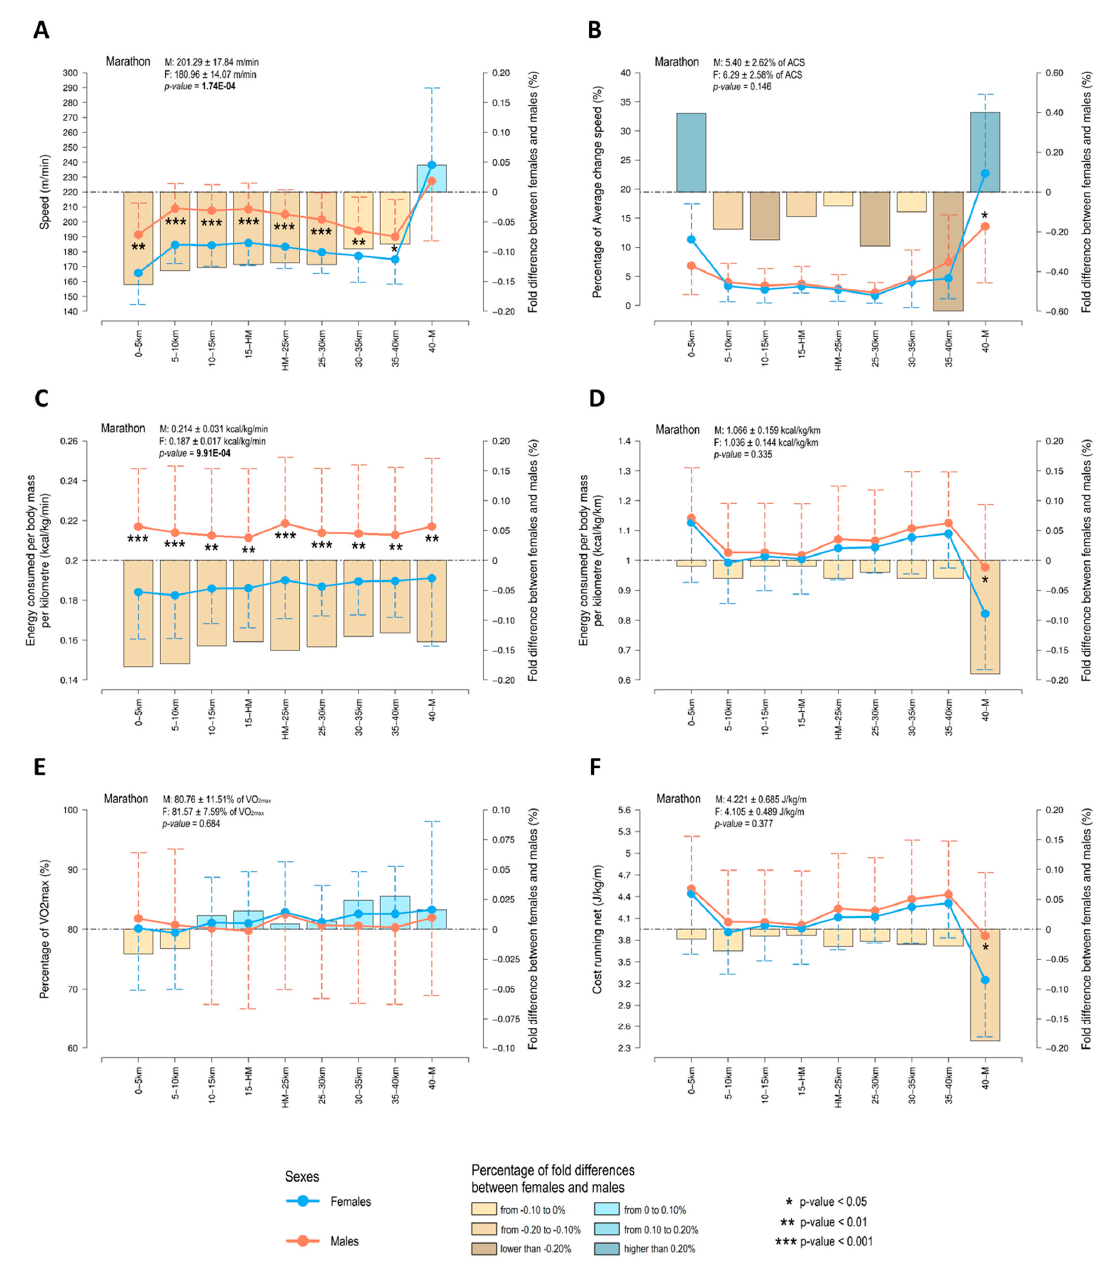
Figure 3. Evolution of ( A ) speed, ( B ) percentage of average change speed, ( C ) relative energy consumed per minute, ( D ) relative energy consumed per kilometer, ( E ) percentage of maximum oxygen uptake, and ( F ) cost running above the standing level. Dots represent the average values for males (orange) and females (blue), and error bars represent the standard deviation of the mean. Bars represent the percentage of sex di ff erence (Gap). Mean values ( ± standard deviation) of each variable analyzed for the whole marathon distance are showed in the corresponding panel. A Mann–Whitney U test was used for testing sex di ff erences. Bold denotes significant di ff erences in values obtained for the whole marathon distance between females (F) and males